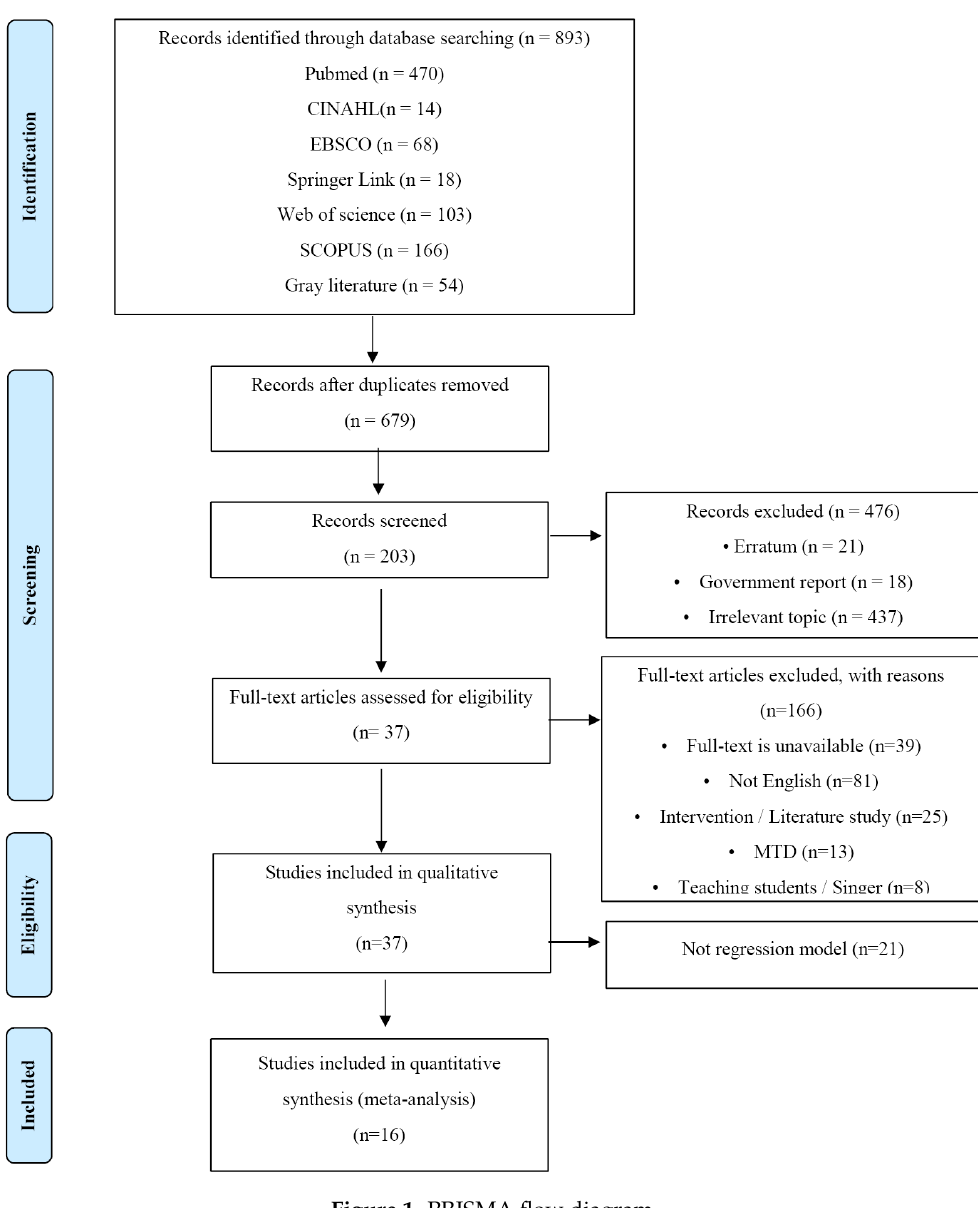
Int. J. Environ. Res. Public Health 2019 , 16 , x Figure 1.